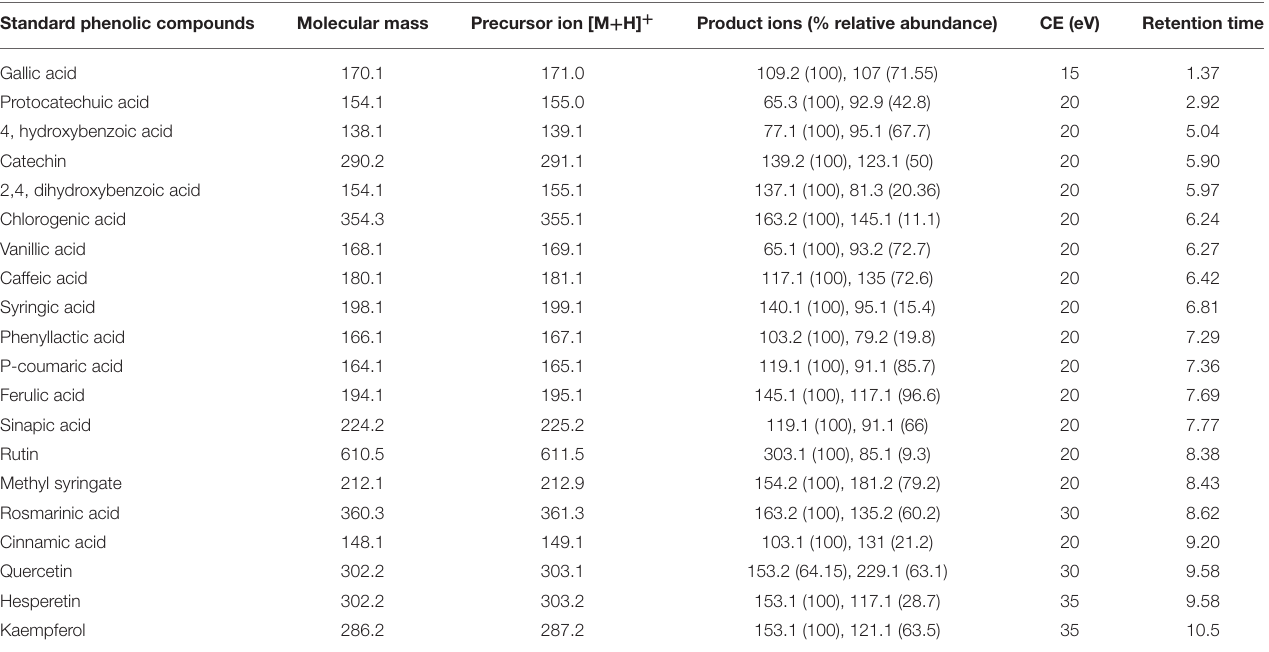
TABLE 4 | LC-MS/MS parameters for detection of phenolic compounds in MRM